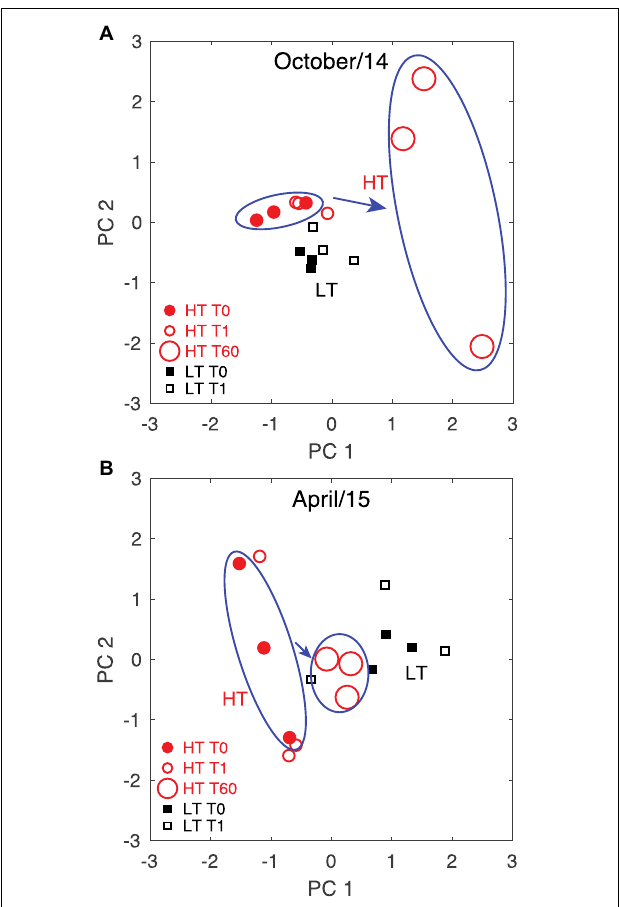
FIGURE 7 | Principal component analyses of DOM composition including long-term incubations for (A) October 2014 and (B) April 2015. T0 and T60 samples are grouped with ellipses for emphasis, while arrows emphasize the extent of DOM transformation over the incubation period based on the first two principal components. The first and second principal components explained 26% and 21% of the variance in (A) and 24% and 13% in (B)